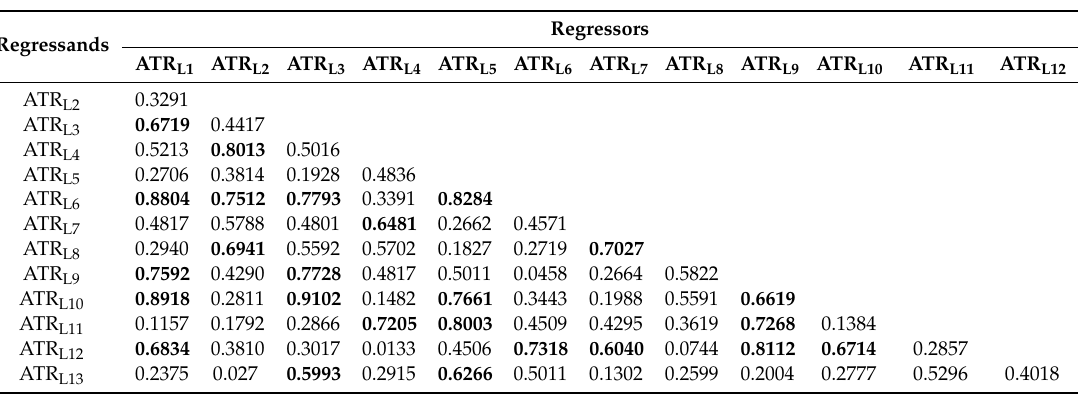
Table 4. Correlation matrix for type II